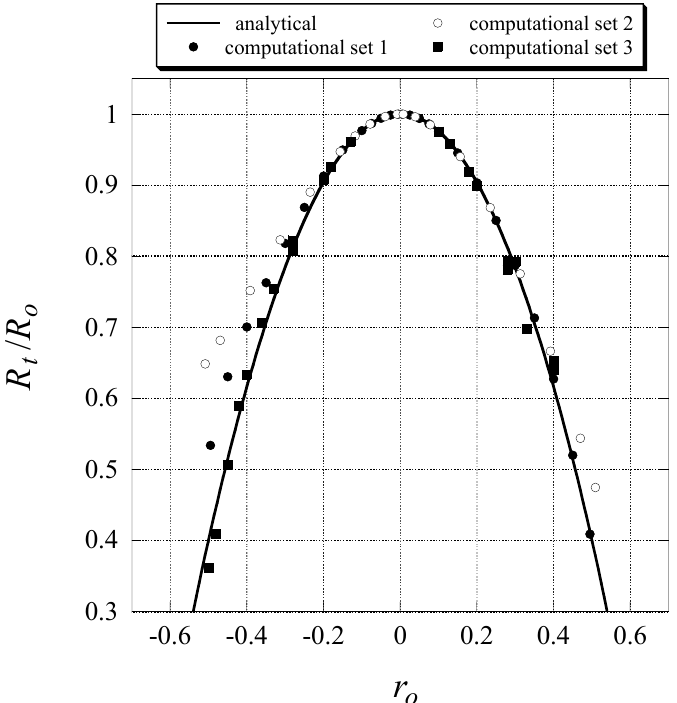
Figure 6. Transitional subcritical values of the scaled Rayleigh number R t as a function of the initial conditions corresponding to three computational sets (using Adomian decomposition method) compared to the analytical solution (weak nonlinear) [17,21]. (Reproduced with permissions from Peter Vadasz, International Journal of Non-Linear Mechanics; published by Elsevier, 2001. Peter Vadasz, Journal of Porous Media; published by Begell House,